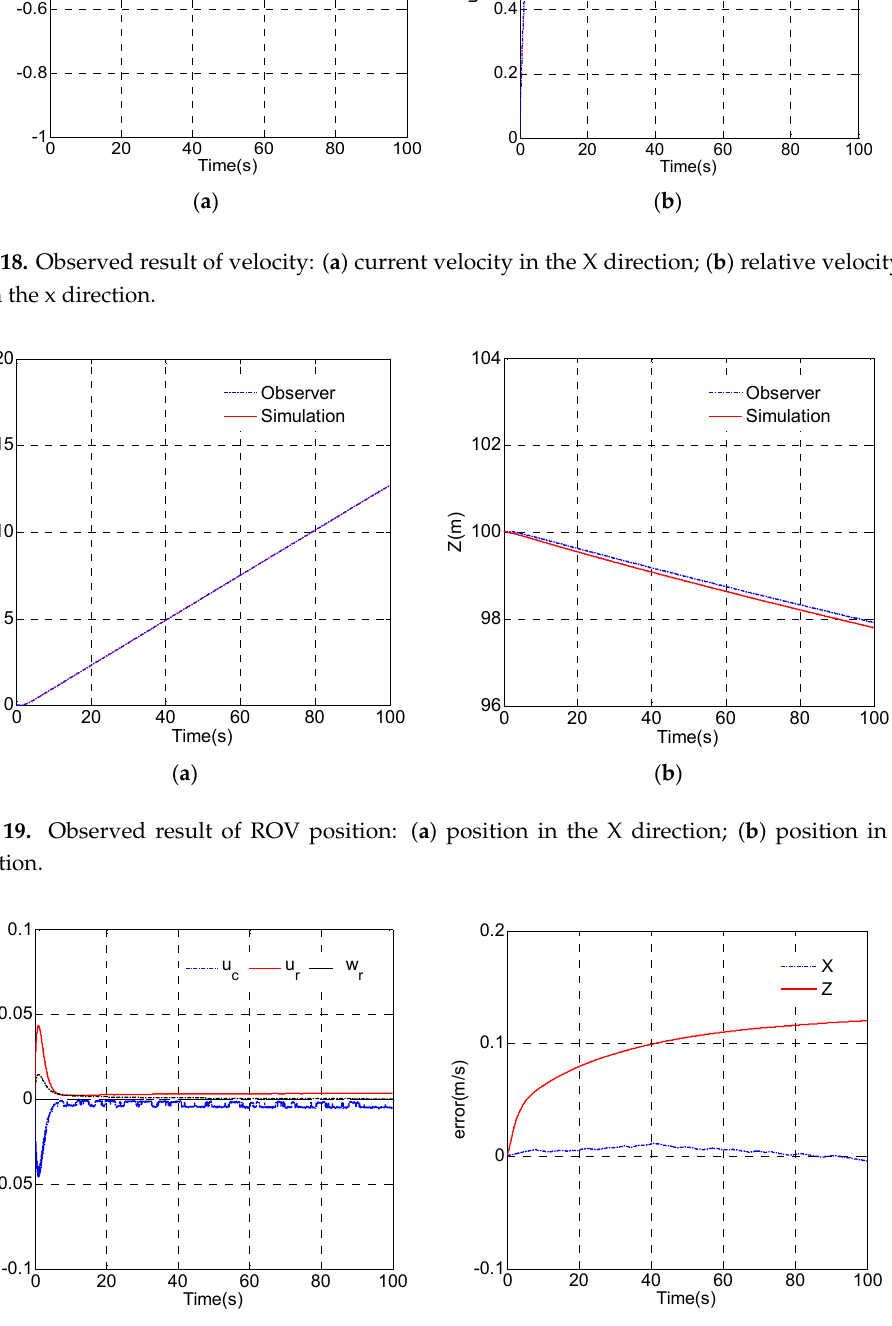
( b ) Figure 21. Cable disturbing force (LPM): ( a ) cable force in the X direction; (b) cable force in the Z direction. When the ROV’s vertical thrust increases from 2000 N to 3000 N , the observation results of the state variables ( b ) Figure 22. Observed result of velocity: ( a ) current velocity in the X direction; ( b ) relative velocity of ROV in the x direction.